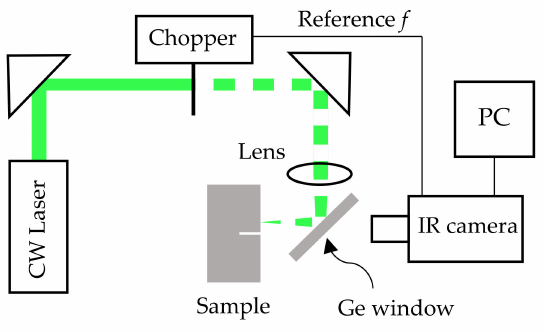
Figure 5. Scheme of the laser-spot lock-in thermography setup.